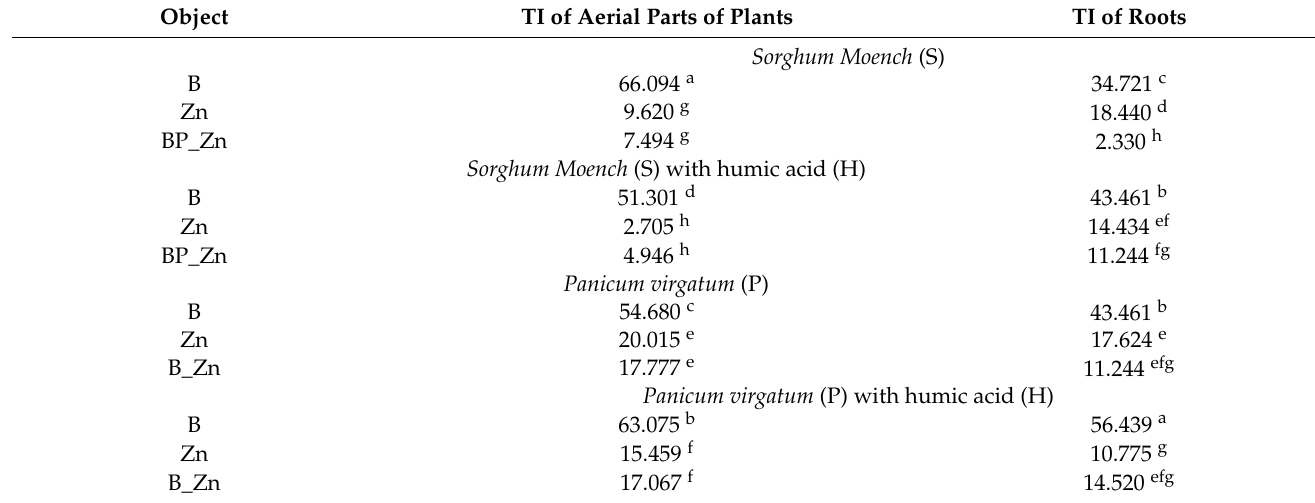
Table 1. Plant tolerance index (TI) of Sorghum Moench (S) and Panicum virgatum (P) (aerial parts of plants and root) to soil contaminated with B, Zn 2+ , and B + Zn 2+